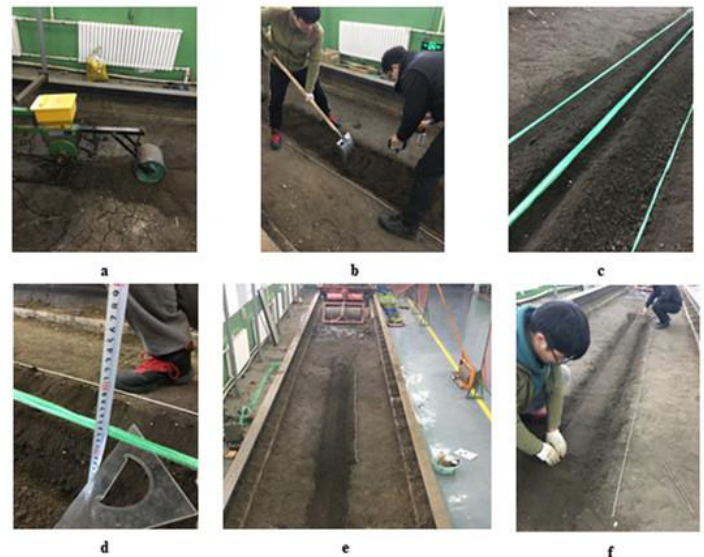
Figure 3. Soil bin test of compacting. ( a ) Soil sample preparation (soil loosening and testing firmness before each trial); ( b ) seeding unit with the compacting component; ( c ) artificial construction of soil furrow; ( d ) recording the positions of the seeds; ( e ) covering soil not disturbing the seeds; ( f ) uncovering the seeds after compacting.